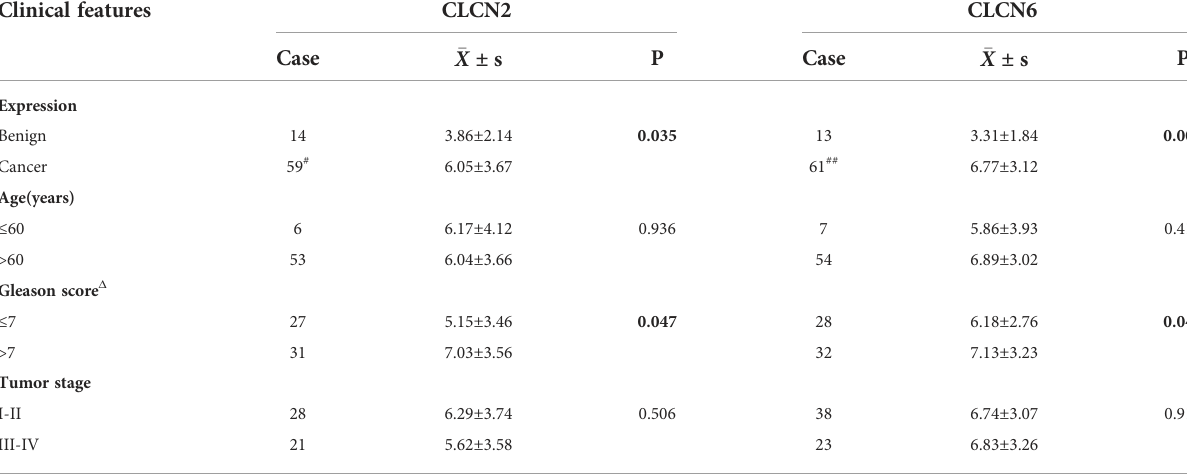
TABLE 1 The relation of CLCN2 and CLCN6 expression to relevant clinical features of PCa patients in our cohort. Clinical